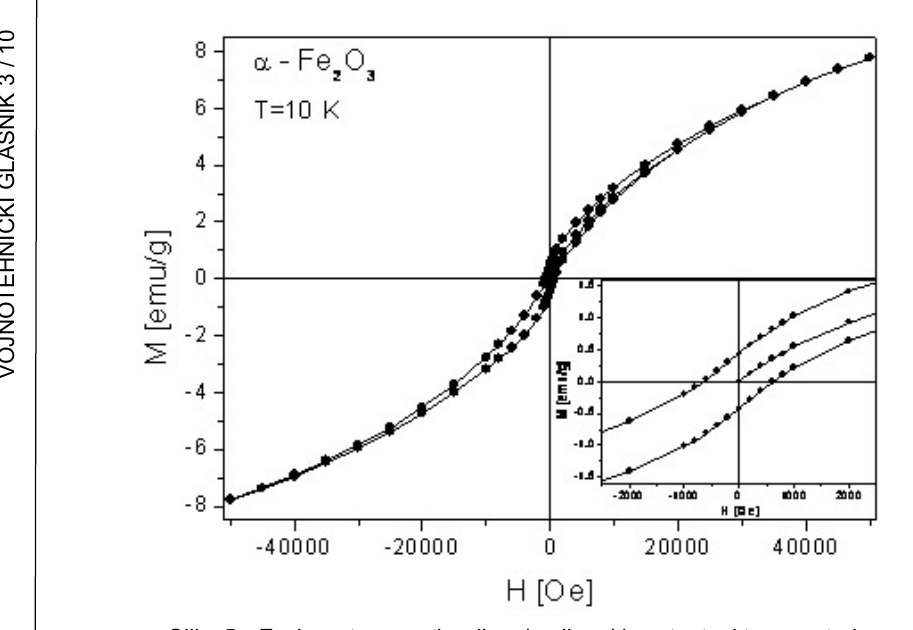
Figure 5 – Magnetization vs. field dependence recorded at 10 K. The inset shows low field magnetization behavior